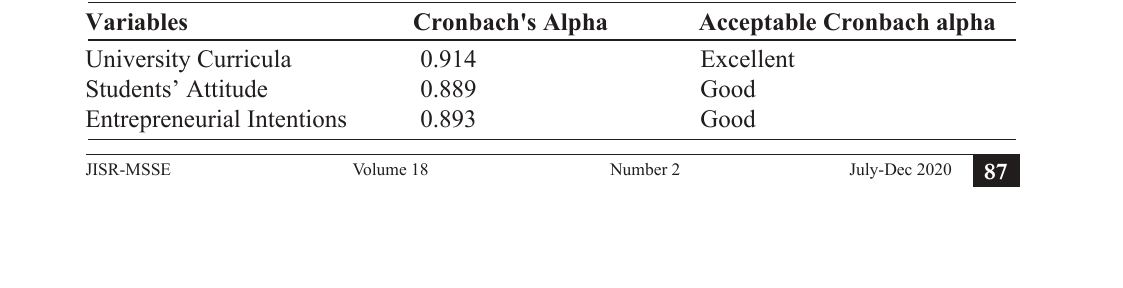
Reliability of Composite